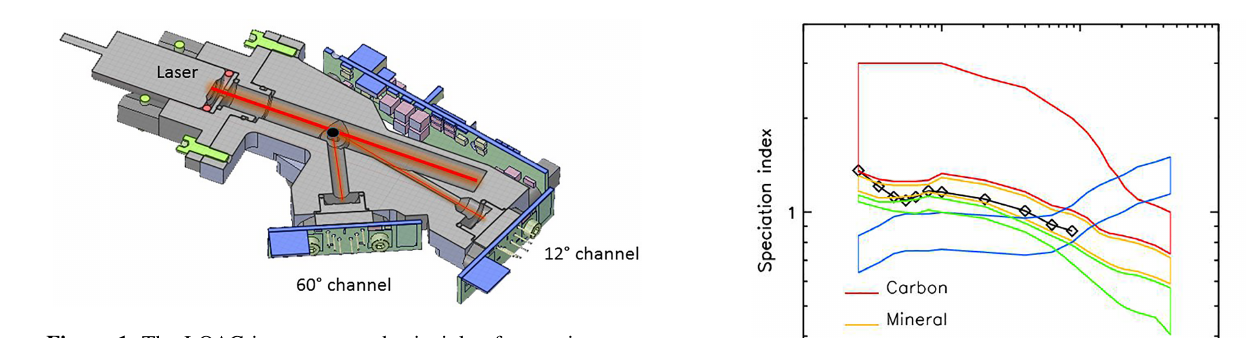
Figure 1. The LOAC instrument and principle of scattering mea- surements at two angles.